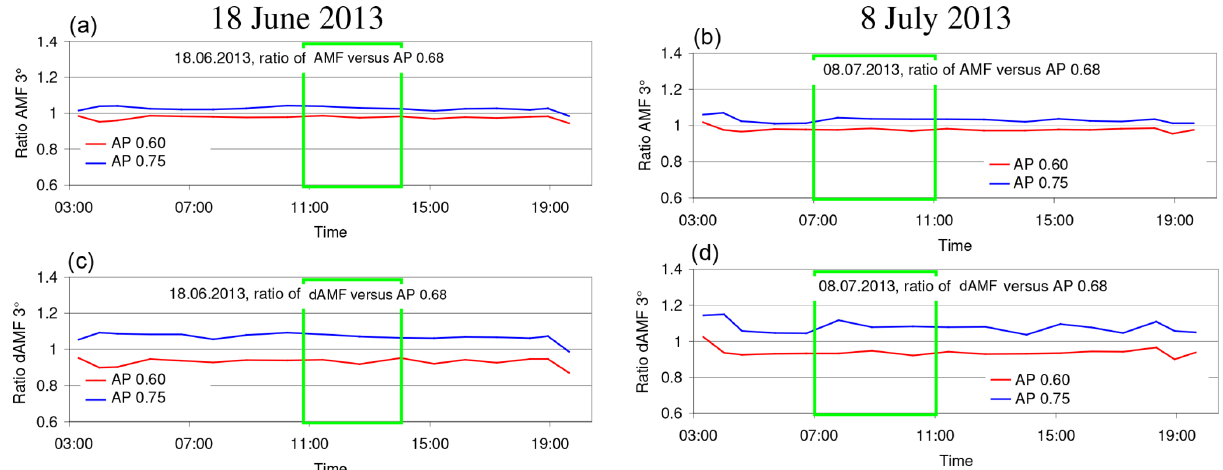
Figure A10. Ratios of the O 4 AMFs (a, b) and O 4 dAMFs (c, d) derived for different aerosol phase functions (HG parameterisation with different asymmetry parameters) vs. those for the standard settings (asymmetry parameter of 0.68) for both selected days.